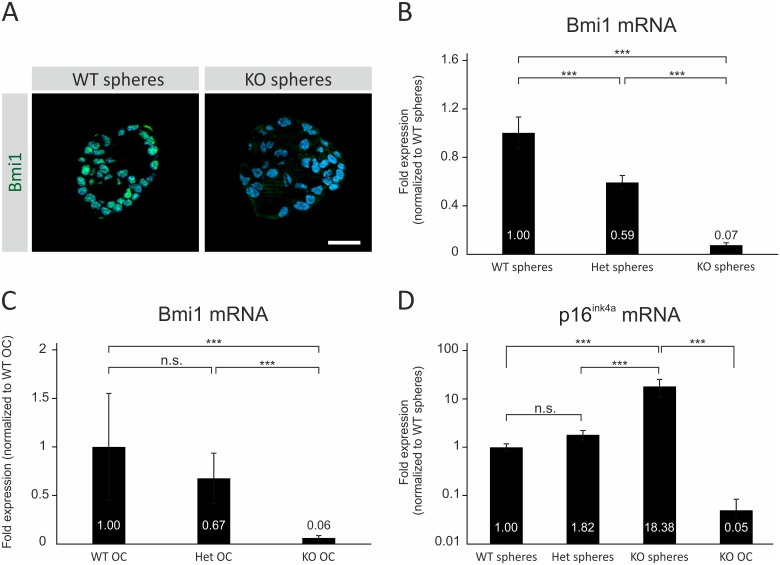
Gene expression changes in the Bmi1 knockout organ of Corti and otospheres.(A) Representative high-magnification images of Bmi1 WT and KO spheres after 5DIV, stained for Bmi1 (green) and counterstained with DAPI (blue). Nuclear Bmi1 signal was detected in the WT, but not the KO, spheres. (B) Quantitative analysis of Bmi1 mRNA levels in the WT, Het and KO spheres by qRT-PCR. The Het spheres showed Bmi1 mRNA levels that are 0.59-fold relative to the WT spheres. Limited amounts of mRNA were detected in the KO spheres, representing 0.07-fold compared with the WT control. (C) Quantitative analysis of Bmi1 transcript levels in the neonatal WT, Het and KO OC by qRT-PCR. When normalized to the WT control, the Bmi1 mRNA levels in the Het OC were 0.67-fold of the WT level. In the KO OC, the level of mRNA detected was 0.06-fold of the WT expression level. (D) Quantitative analysis of p16ink4a transcript levels in the WT, Het and KO spheres by qRT-PCR. In the Het spheres, p16ink4a is upregulated 1.82-fold relative to the WT spheres. The KO spheres show an 18.38-fold upregulation of p16ink4a compared to the WT spheres. In the neonatal KO OC, only scarce amounts of p16ink4a mRNA were detected, representing 0.05-fold compared to the WT spheres. WT: wildtype, Het: heterozygous, KO: knockout. n.s.: not significant. ***p<0.001.